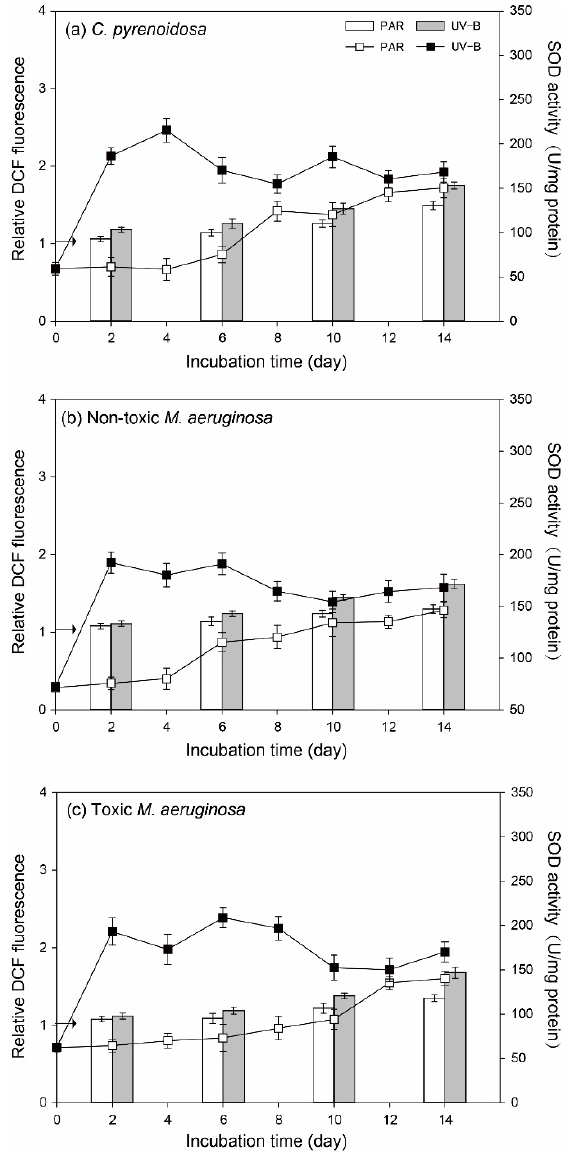
Figure 9. ROS in the cells of three species (vertical bar) and algal SOD activity (line and scatter) during the incubation in the PAR and UV ‐ B treatments under nutrient enrichment conditions (the arrow indicates the initial value of ROS contents).